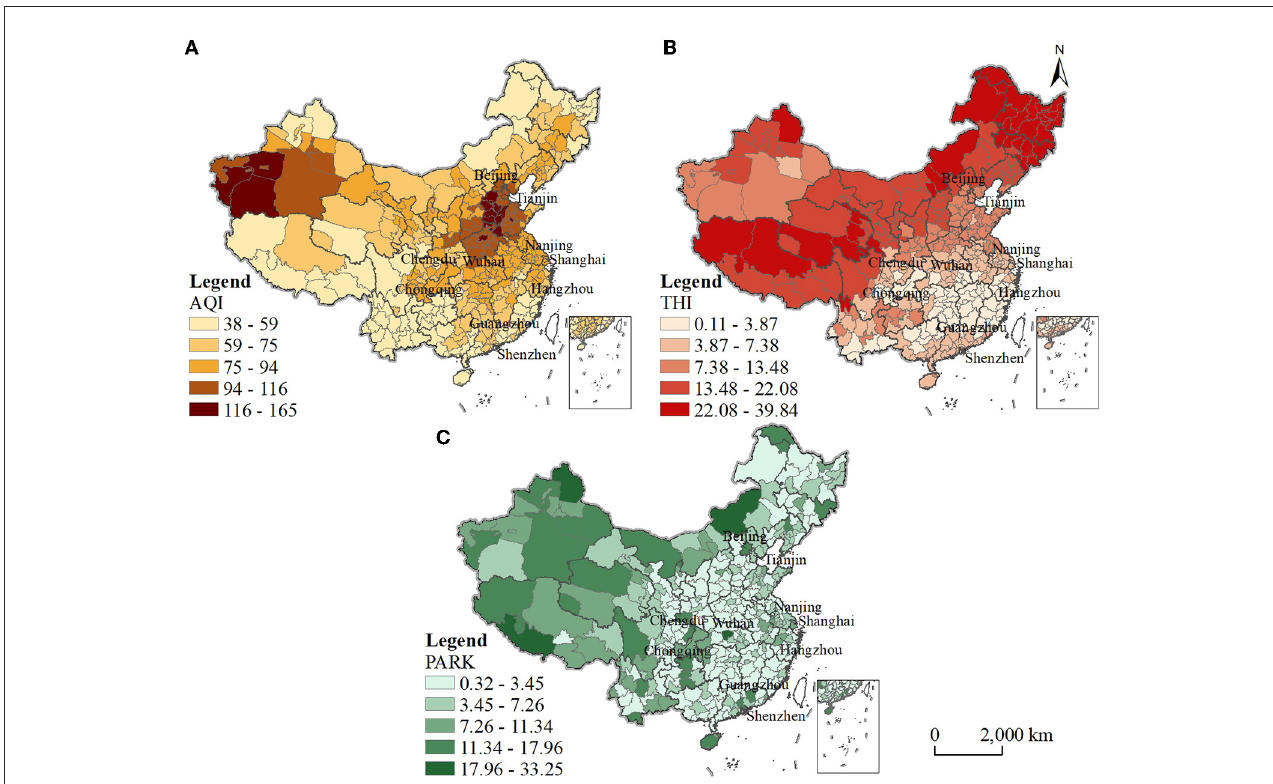
FIGURE4 The spatial pattern of three environmental health factors. (A) Air quality index. (B) Climate comfort index. (C) Per capita park green